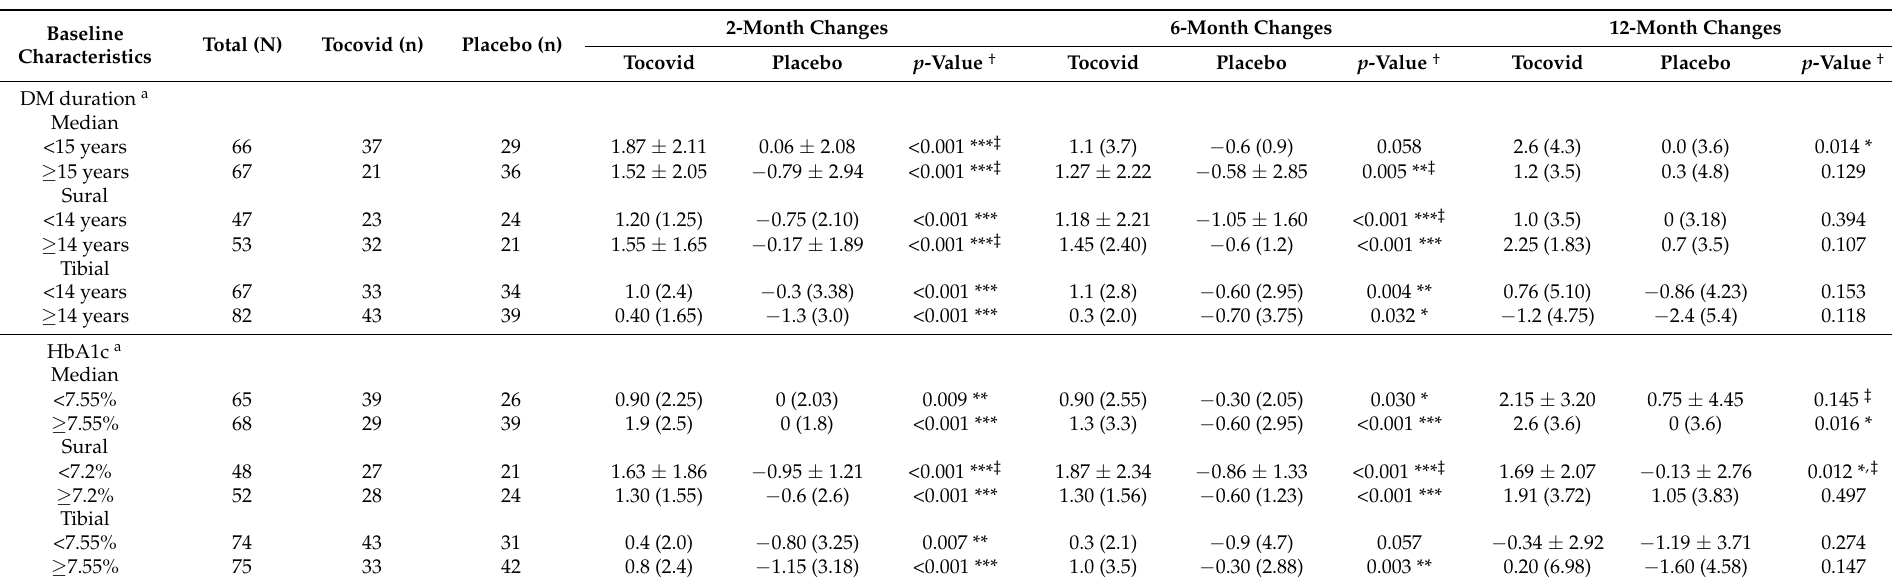
Table 9. Subgroup analysis comparing changes in conduction velocity (CV) stratified according to the duration of diabetes and HbA1c. Baseline